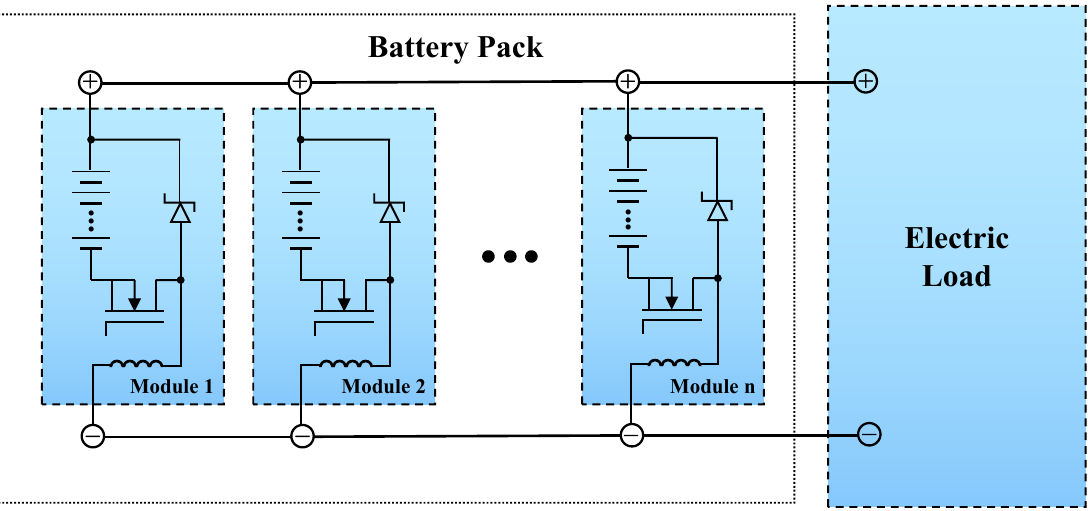
Figure 1. System diagram of parallel buck regulated battery modules. In each module, the battery is represented by a series connection of battery cells to create the desired OCV, while a BMS with MOSFET microcontroller controlled switch with a flyback diode and inductor are used for regulation of the battery voltage on the parallel